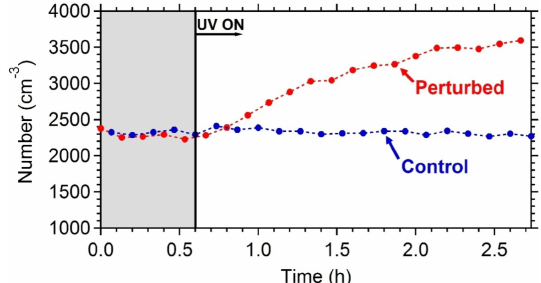
Figure 6. The wall-loss-corrected SMPS-measured aerosol number concentration. HONO was added only in the perturbed chamber at t = 0 . 4h to produce OH under UV illumination. The shaded area indicates that the chambers were dark.